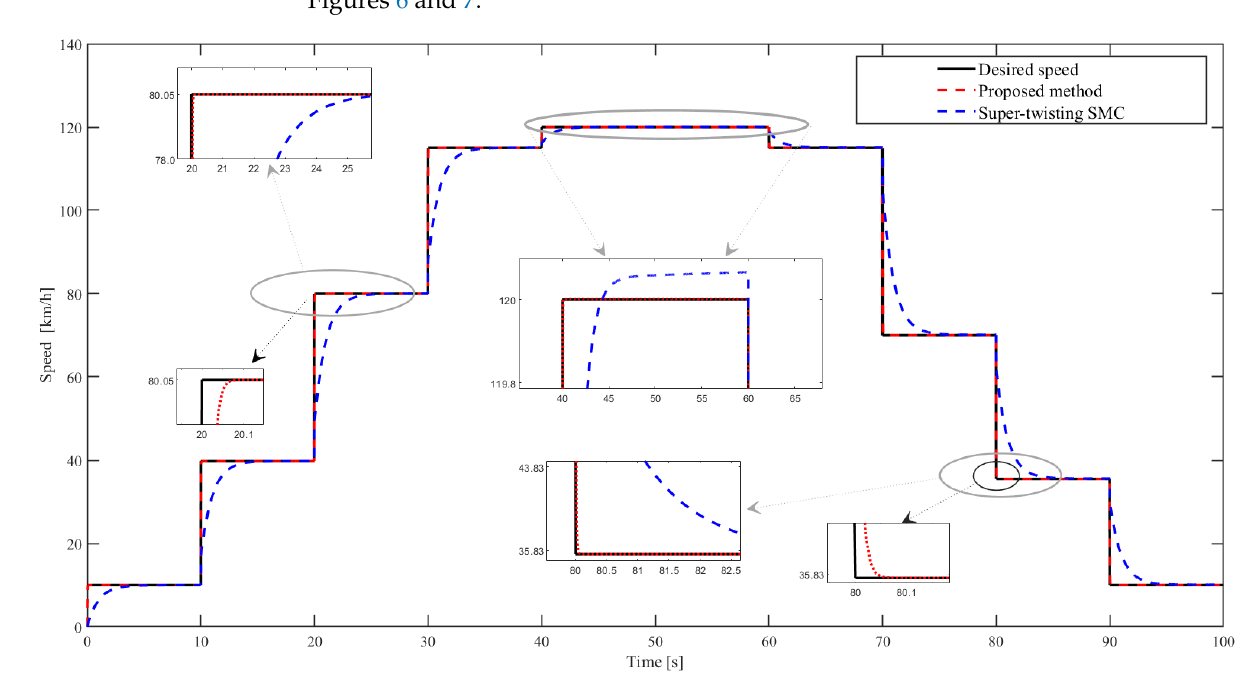
Figure 6. Speed profile tracking responses.